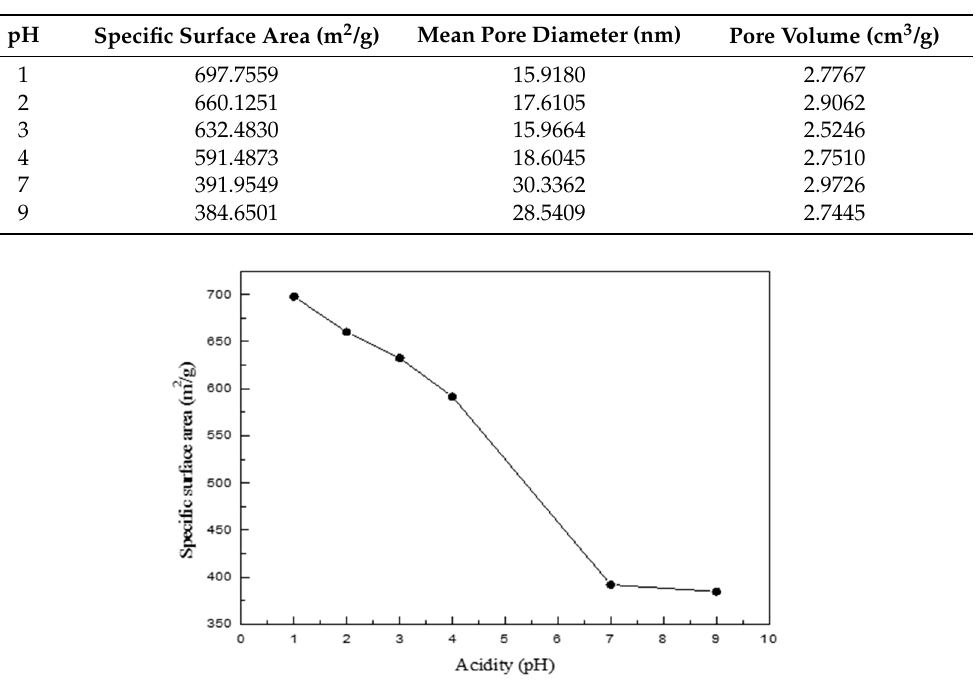
Table 3. Textural properties of the silica aerogels depending on the sol pH.